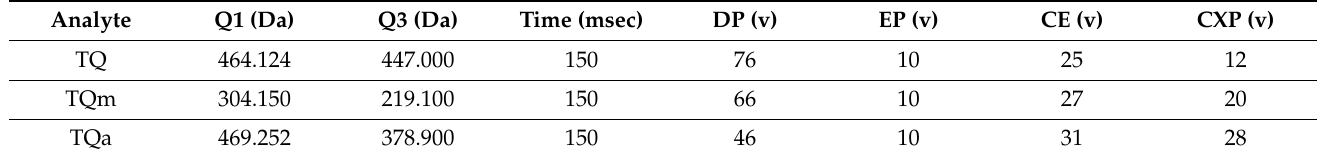
Table 6. Mass transitions and voltages used for the analysis of TQ and 5,6-OQTQ in blood and plasma on the 4000 Qtrap.